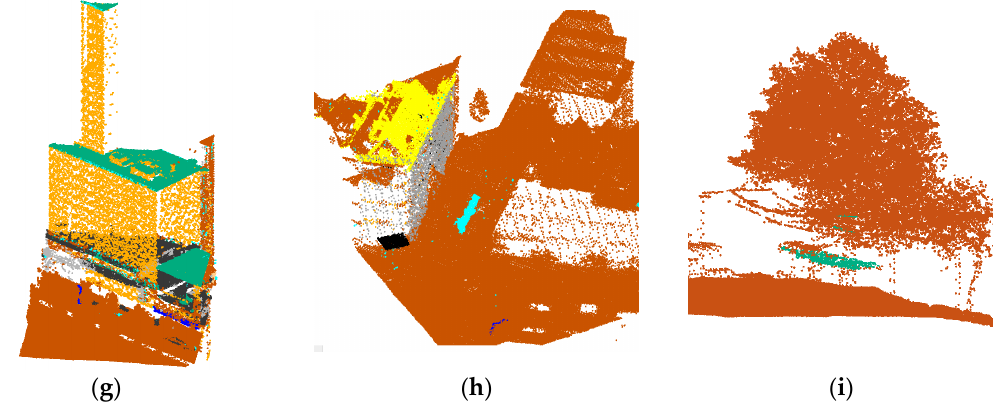
Figure 18. Successfully detected and classified examples of change. ( a ) newly built dormers on roofs, ( b ) lack of data for roofs in one epoch (unknown) and lack of data for walls and ground because of occlusion, ( c ) undefined changes on roofs, ( d ) newly built constructions above roofs, ( e ) cars parked on top of buildings, ( f ) newly built and demolished buildings (two examples in one image), ( g ) add-on building constructions, ( h ) insulation layers added to roofs. ( i ) new building roof under trees.